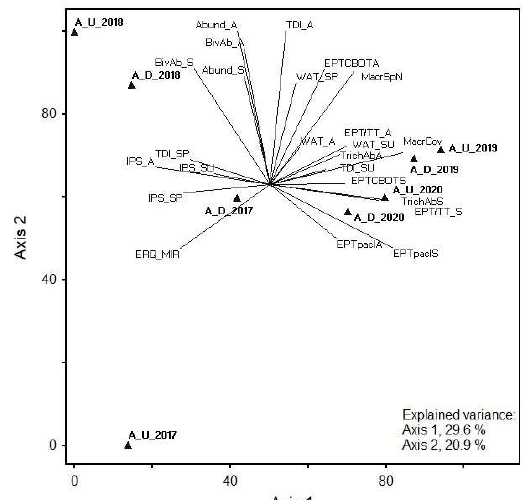
Figure 3. PCA showing the relationship between phytobenthos, macrophyte, and selected macroinvertebrate metrics at two Age stream sites in 2017–2020. Abbreviations: Sampling site code: A, Age;